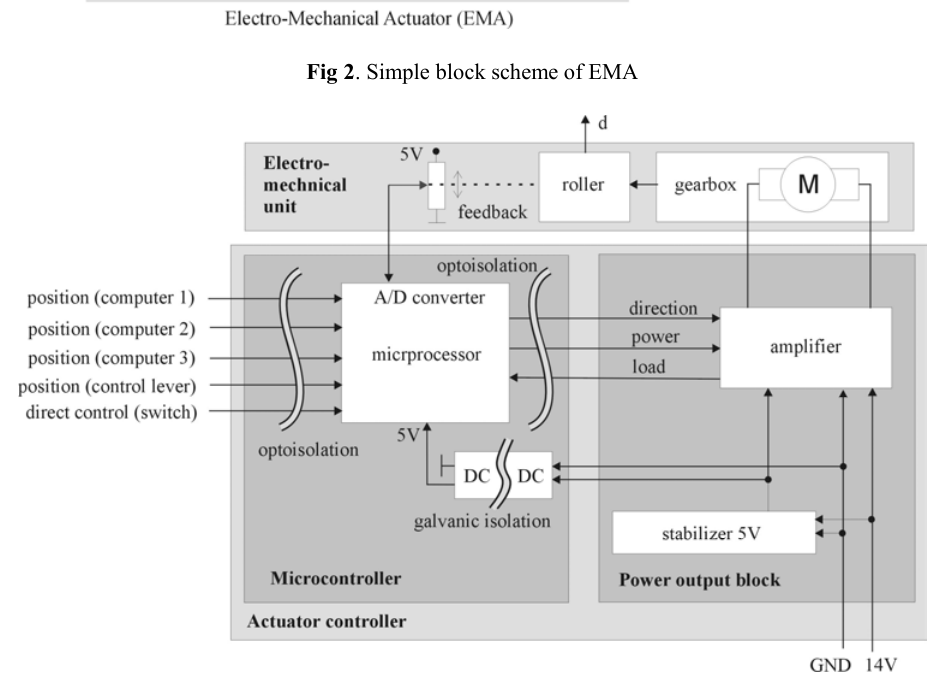
Fig 3. Controller hardware